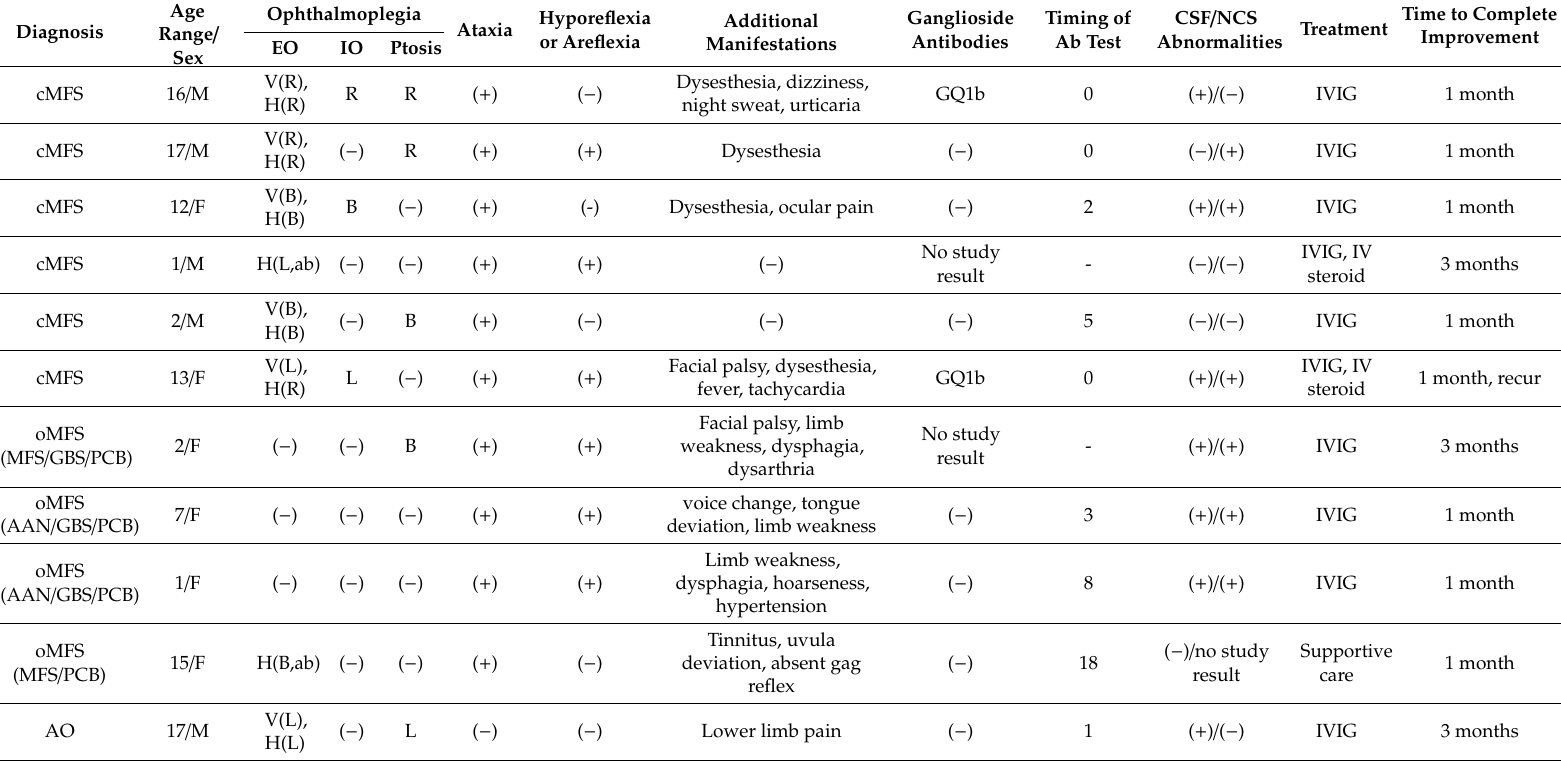
Table 1. Demographic and clinical characteristics of pediatric Miller Fisher syndrome